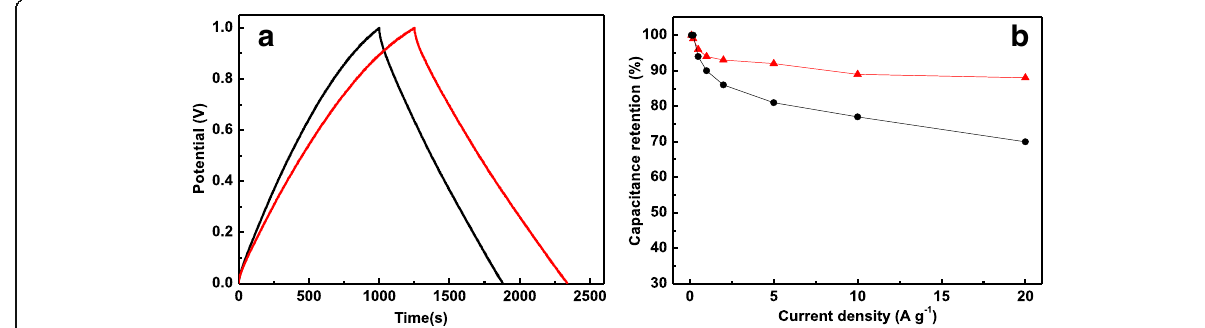
Fig. 6 GCD tests and capacitance retention. a GCD curves at the current density of 0.1 A g − 1 and b capacitance retention at various current densities of the CGACF ( red line and symbol ) and AC samples ( black line and symbol )